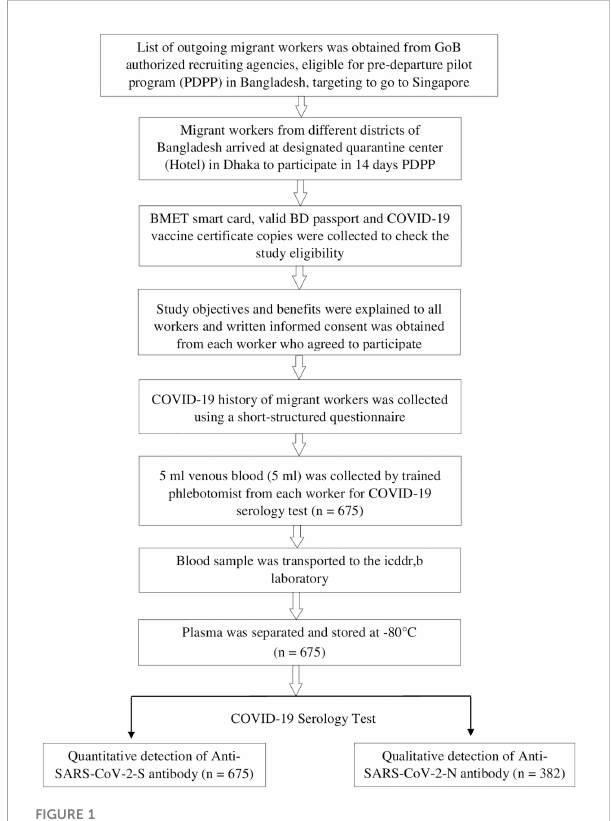
FIGURE 1 Flowchart showing enrollment, data and sample collection, and evaluation of COVID-19 post vaccine antibody response among the migrant workers, Bangladesh,